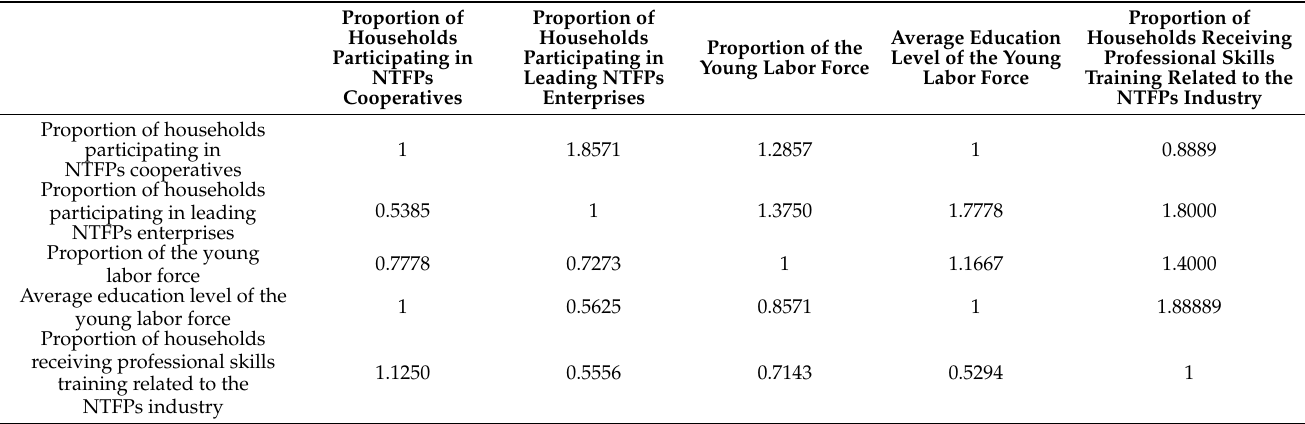
Table 5. C4-D: The judgement matrix for the sustainability of income